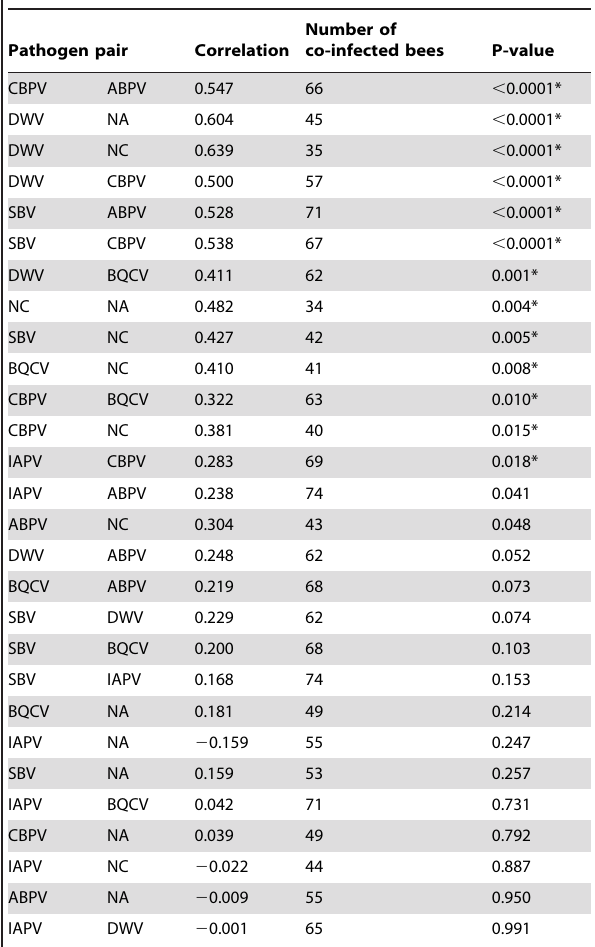
Number of co-infected